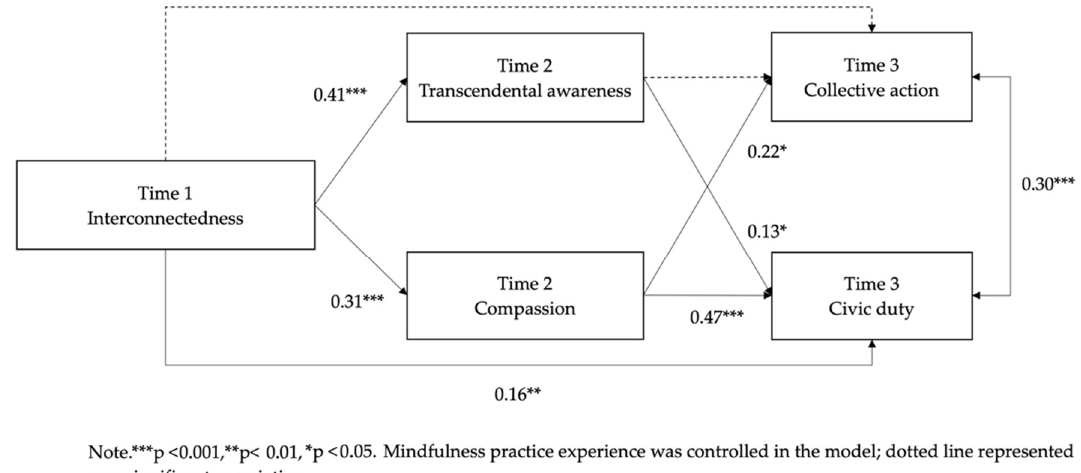
Figure 1. Standardized estimates of the hypothesized